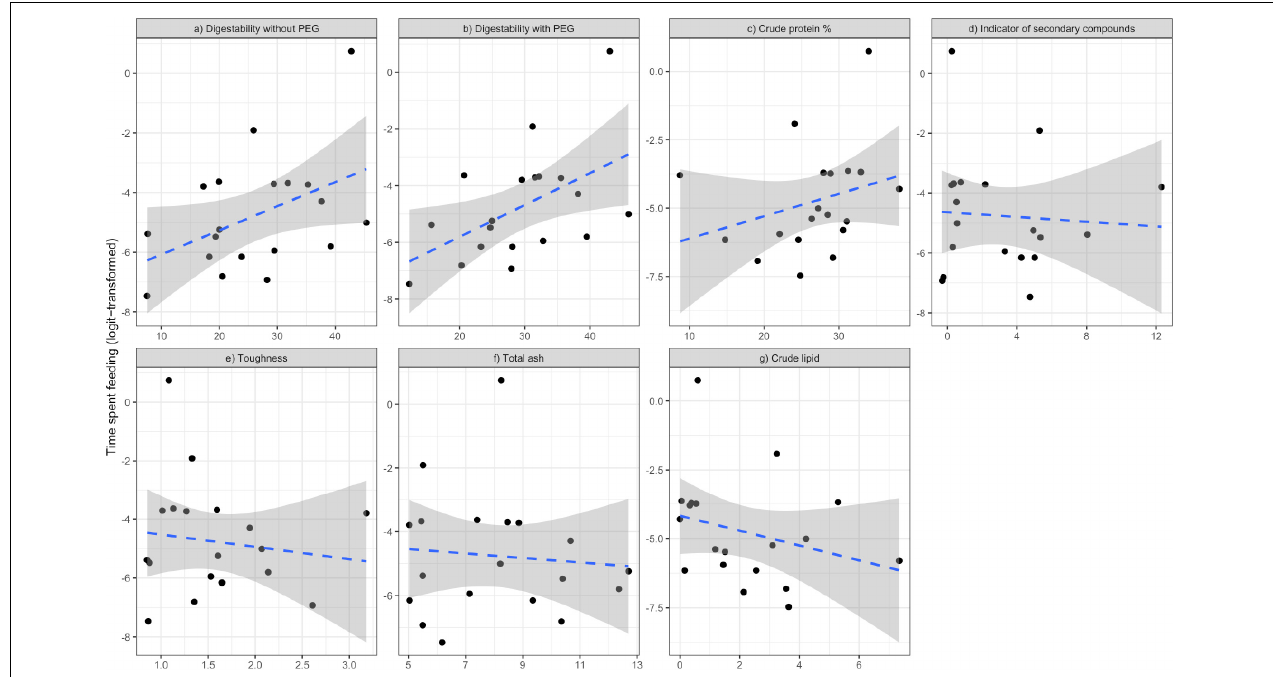
FIGURE 2 | Relationships of the proportion of time spent feeding (logit transformed) with in vitro digestibility (a,b) , chemical properties (c,d,f,g) and toughness (e) of consumed leaves by study guerezas, based on the model selection Table 4 . Blue dotted lines and shaded areas represent the linear regressions estimated by the “lm” method in R for the observed samples and their 95% confidence interval ranges,